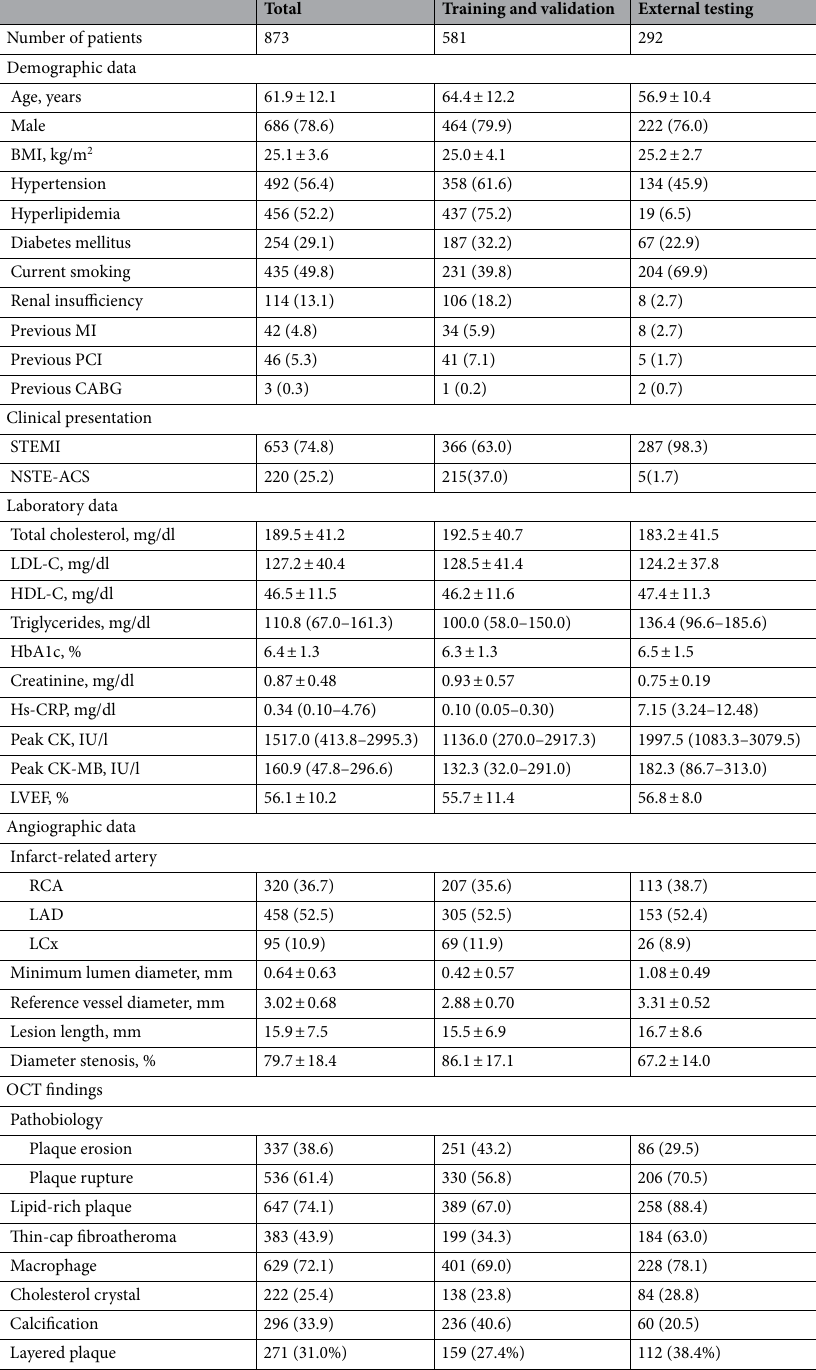
Table 1. Patient and lesion characteristics. Values shown are n (%), mean ± standard deviation, or median (25th–75th percentile). BMI body mass index, CABG coronary artery bypass graft, CK creatine kinase, CK-MB creatine kinase-MB, HbA1c hemoglobin A1c, HDL-C high-density lipoprotein-cholesterol, Hs-CRP high- sensitivity C-reactive protein, LAD left anterior descending artery, LCx left circumflex artery, LDL-C low- density lipoprotein-cholesterol, LVEF left ventricular ejection fraction, MI myocardial infarction, NSTE-ACS non-ST-segment elevation acute coronary syndrome, PCI percutaneous coronary intervention, RCA right coronary artery, STEMI ST-segment elevation myocardial